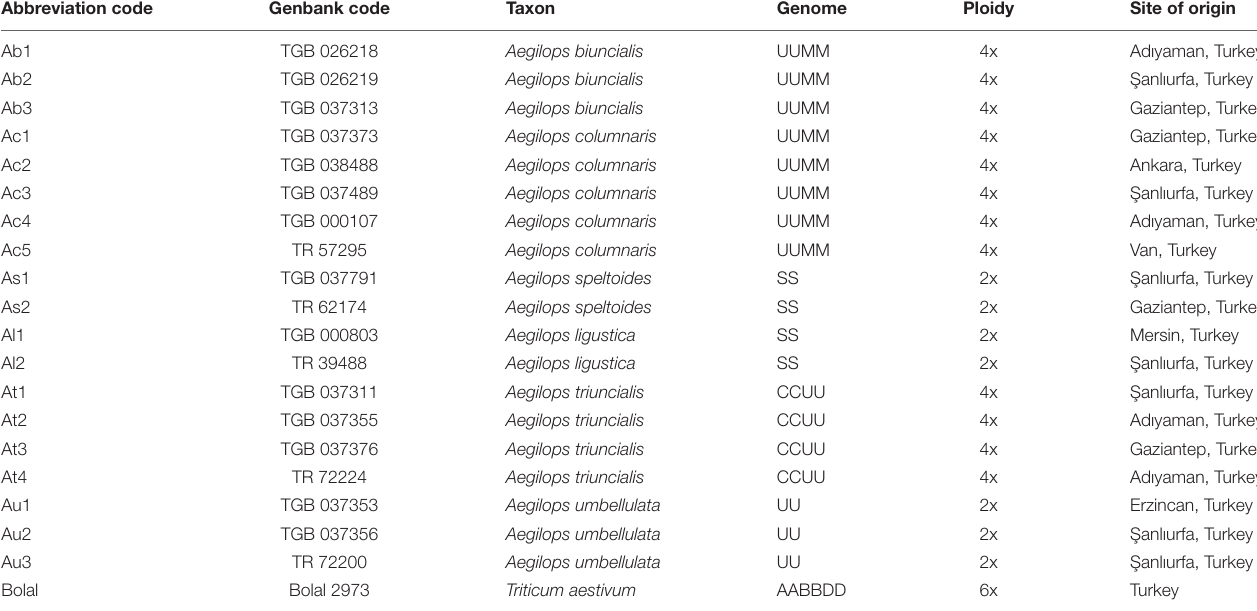
TABLE 1 | Abbreviation code, Genbank code, genome, ploidy, and the site of origin of the 19 Aegilops accessions along with the bread wheat cultivar, Bolal 2973 used in this study. Abbreviation